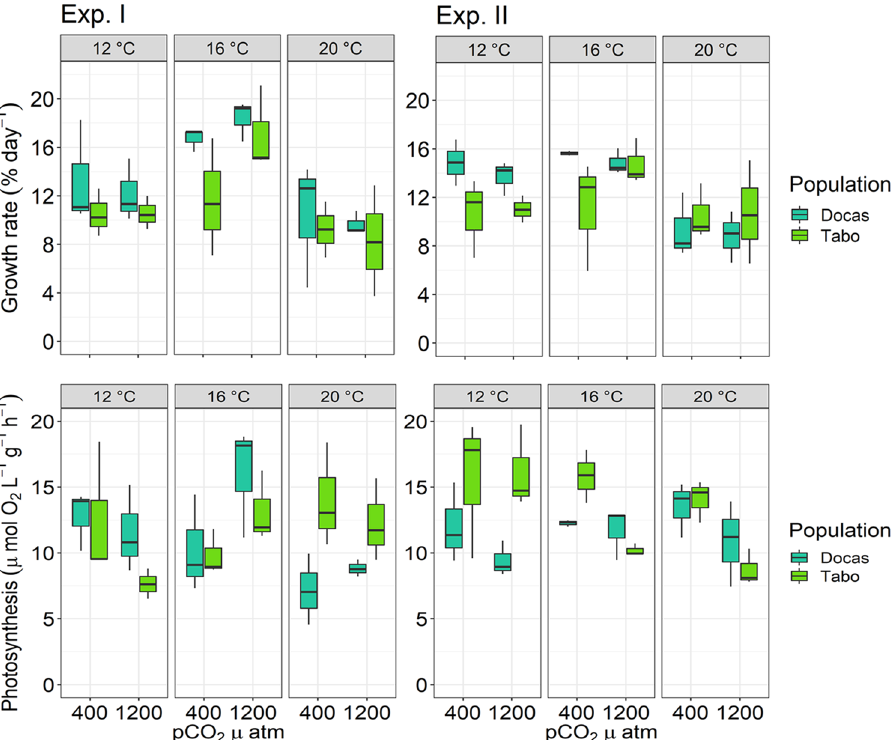
Figure 1. Relative growth rates (% day −1 ) and photosynthesis of juvenile Macrocystis sporophytes from Las Docas and El Tabo, incubated for three weeks (Experimental trial I and II) under three temperature (12, 16 and 20 °C) and two pCO 2 treatments (~ 400 and 1200 µatm). Box-plots showing median size (line within box), 25th and 75th percentiles (ends of box), and minimum and maximum distribution of the data